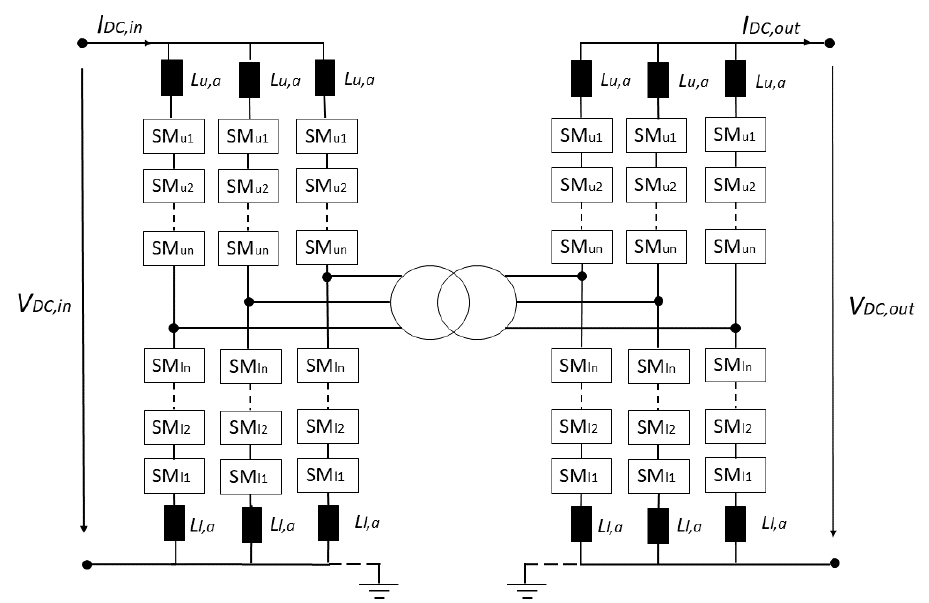
Figure 3. Isolated three-phase DC/DC converter